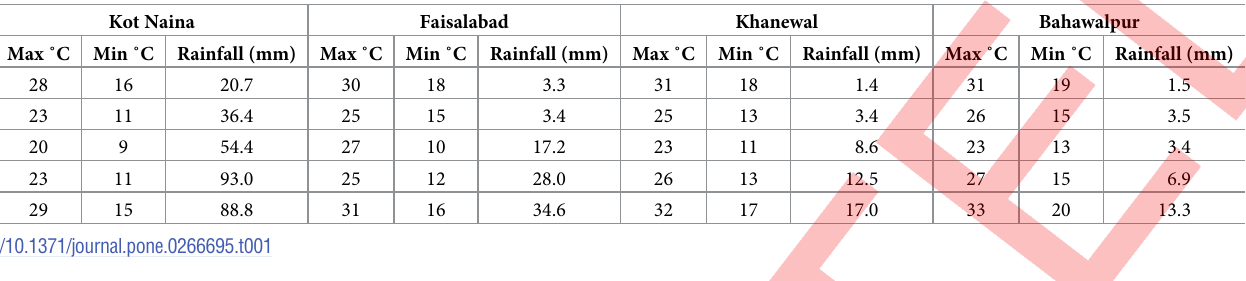
Table 1. Historical (2010–2020) average maximum temperature, average minimum temp and average rainfall of experimental sites during wheat growing season